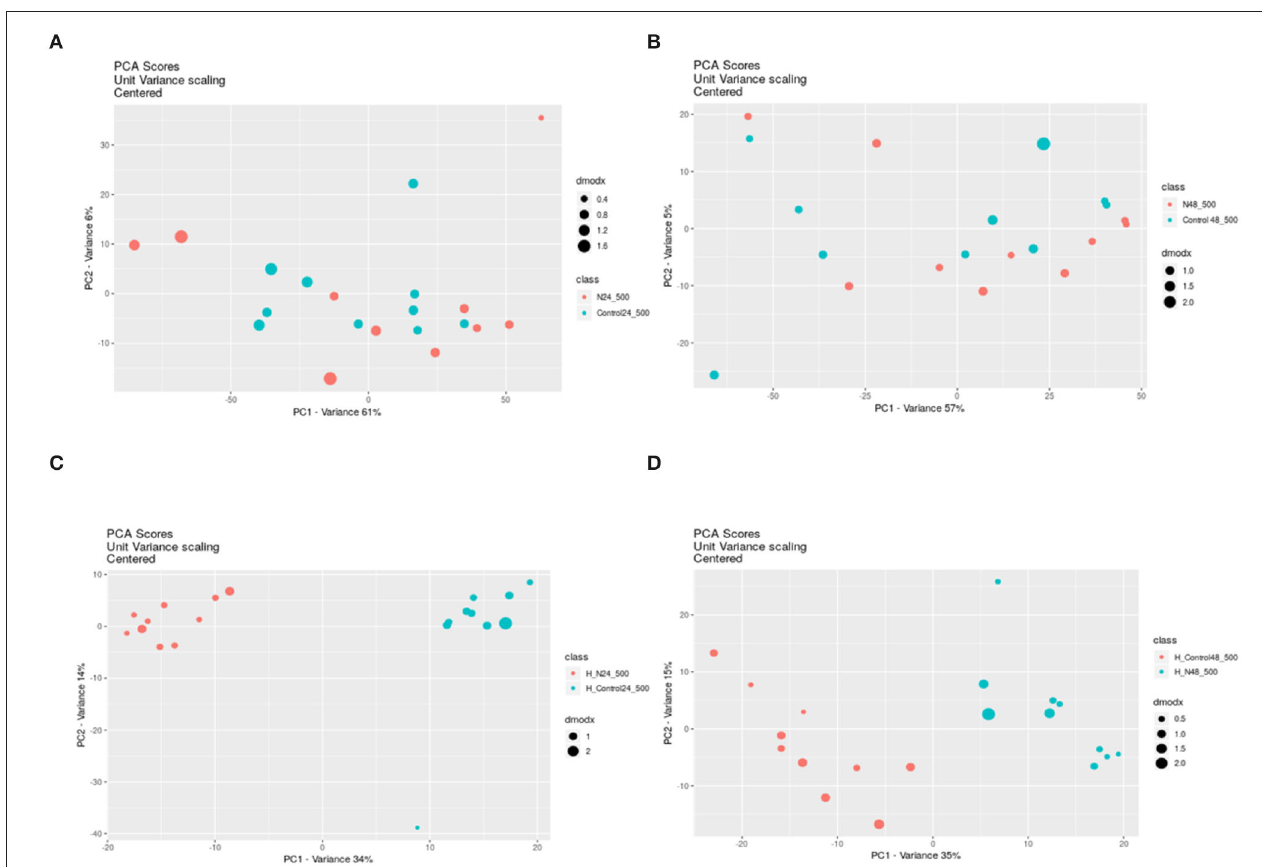
FIGURE 1 | The PCA scores from pairwise analysis (XC–MS online) of samples obtained from control and treated bacteria extracted with different solvents and after different times. PCA was applied to decrease high dimensionality of metabolomic data by the reduction of high-dimensions data into lower dimensions and retention of as much information as possible. PCA shows if any separation between groups of samples exists. Chloroform-methanolic extracts after 24h exposure (A) and after 48h exposure (B) ; Methanolic–aqueous extracts after 24h exposure (C) and after 48h exposure (D) ; N – propolis treated bacteria (blue dots), Control–control bacteria (red dots). DmodX is the distance between the original data point and the model plane in X-space, it identifies the outliers.